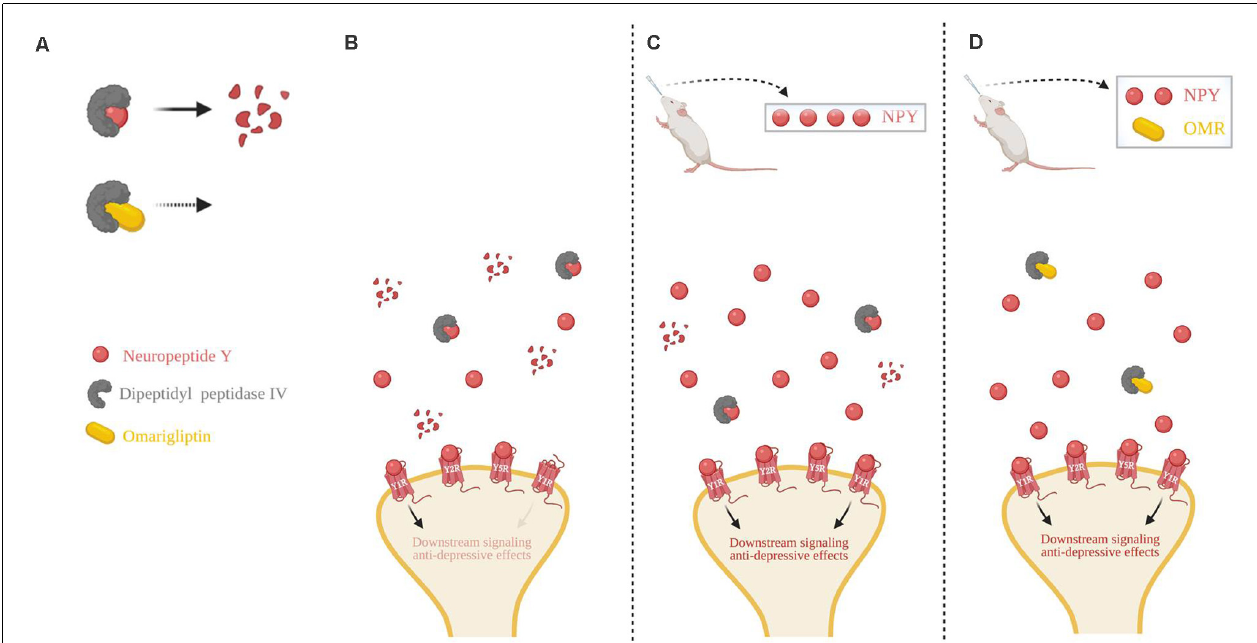
FIGURE 5 | Schematic of intranasal NPY treatment and role of NPY cleavage in females. (A) The first 2 N-terminal amino acids of NPY are cleaved by dipeptidyl peptidase IV (DPP4), changing it from a pan-receptor agonist to a Y2R and Y5R selective agonist. Omarigliptin (OMR) blocks the activity of DPP4, preventing NPY’s cleavage. (B) Without any exogenous delivery of the drug, DPP4 cleaves NPY resulting in a low concentration of the full-length NPY peptide. (C) Delivery of a high dose of intranasal NPY rapidly reaches the central nervous system and results in a higher concentration of the full-length NPY peptide in the synapse, despite some cleavage by DPP4. (D) Intranasal administration of OMR and a lower dose of NPY results in a similar concentration of the full-length NPY peptide as compared to delivery of a high dose of intranasal NPY in part due to the inhibition of its cleavage. Higher synaptic availability of the full-length NPY peptide is likely able to have greater activation of Y1R, compared to the NPY cleavage product. Illustration created with BioRender ©